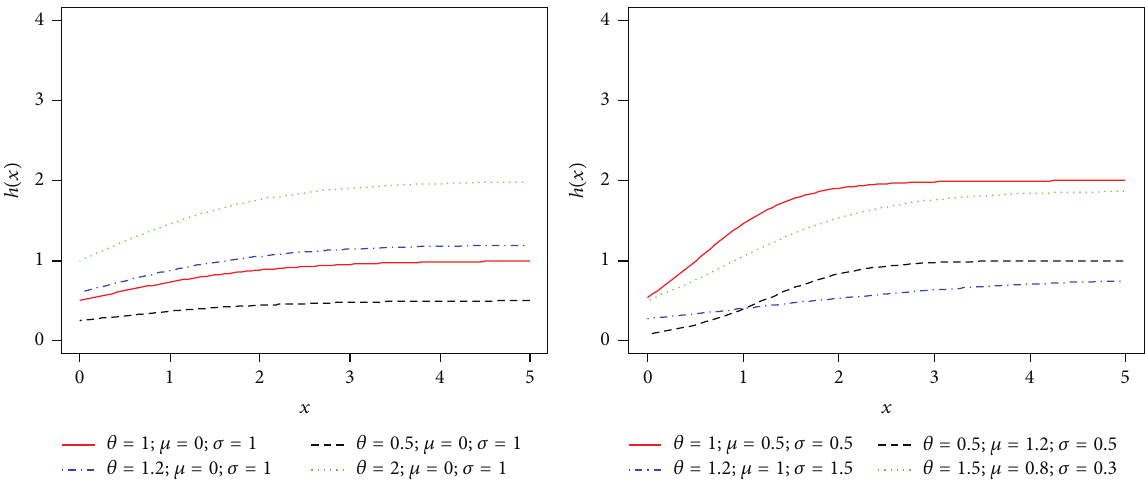
Figure 2: Hazard rate function of the type I generalized half-logistic distribution for the indicated values of 𝜃 , 𝜎 , and 𝜇 .